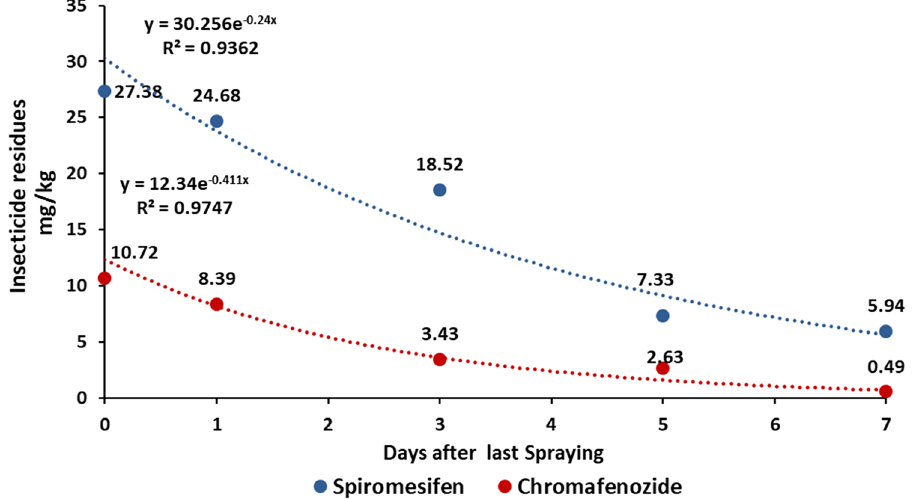
Figure 1. Dissipation patterns and half-lives of insecticides in